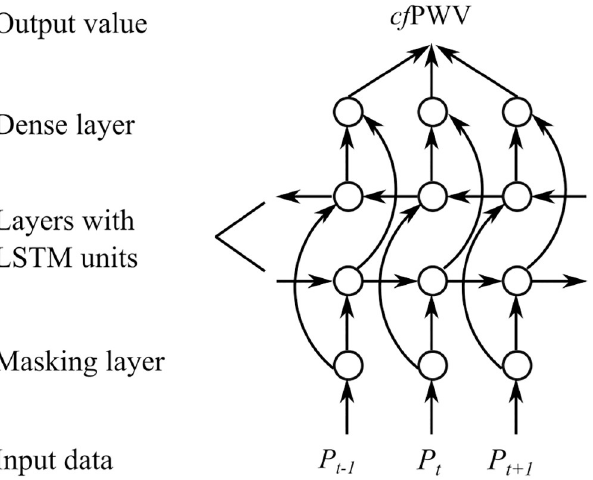
Fig 3. Schematic illustration of the recurrent neural network structure used to estimate pulse wave velocity from the entire radial pressure wave. P +1, cf PWV is the carotid-femoral pulse wave